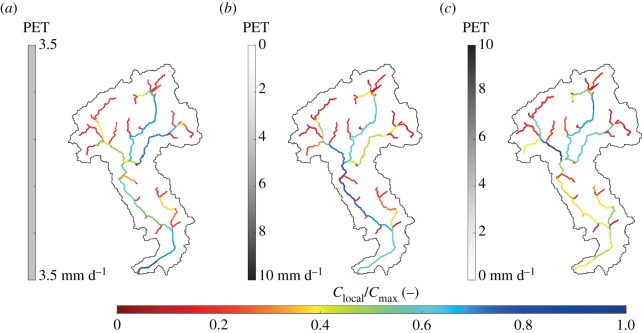
The ratio of the local connectivity to the maximum local connectivity assuming h∗=250 mm, 〈P〉 = 150 mm/season and (a) uniform 〈PET〉, (b) 〈PET〉 increasing downstream and (c) 〈PET〉 decreasing downstream.